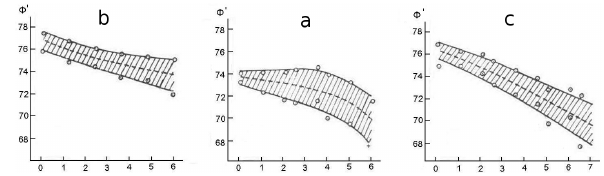
Figure 14. Locations of the northern and southern edges of the dayside auroral oval in dependence on the Q index of the magnetic activity ( a 06:00–10:00MLT, (b) 10:00–14:00MLT, and (c) 14:00–18:00MLT). The dashed line represents the centre of the oval (Feldstein and Starkov, 1967a).